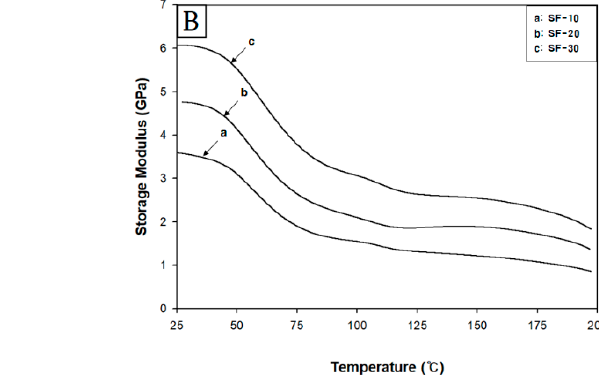
Figure 7. Variation in the storage modulus of the ( A ) MF-NiCF/PA6 and ( B ) SF-NiCF/PA6 composites with various NiCF contents.